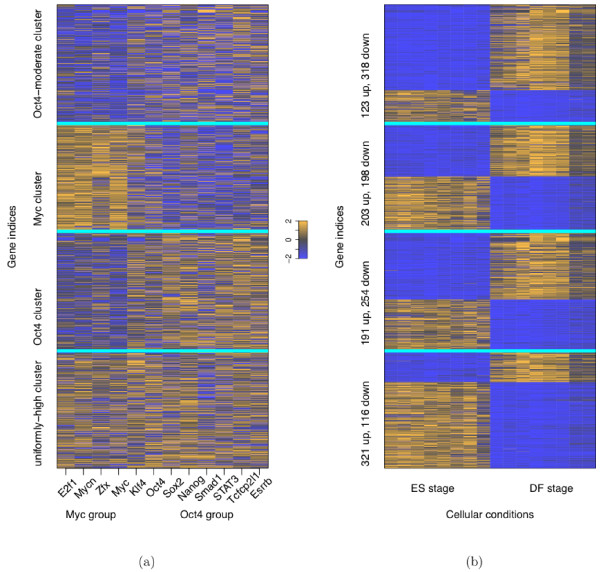
Association scores and expression profiles with genes aligned between (a) and (b). (a) Association scores of the ES genes that are in the uniformly-high cluster, the Oct4 cluster, the Myc cluster, and the Oct4-moderate cluster, with cyan-colored horizontal lines indicating boundaries between the clusters. (b) Gene expression profiles with the first 8 conditions corresponding to ES stage and the rest corresponding to DF stage, annotated by the number of ES-up (indicated by "up") genes and ES-down ("down") genes in each cluster. Note that genes within a cluster are sorted according to their expression fold change. Association scores and gene expression profiles are the same as the ones generated in their original papers. Specifically, the association scores are log-transformed and quantile-normalized [14]; the gene expression profiles in [16] are normalized by the invariant set method implemented by dChip [37]. For display purpose, both the association scores and the gene expression profiles are rescaled to the range between -2 and 2.